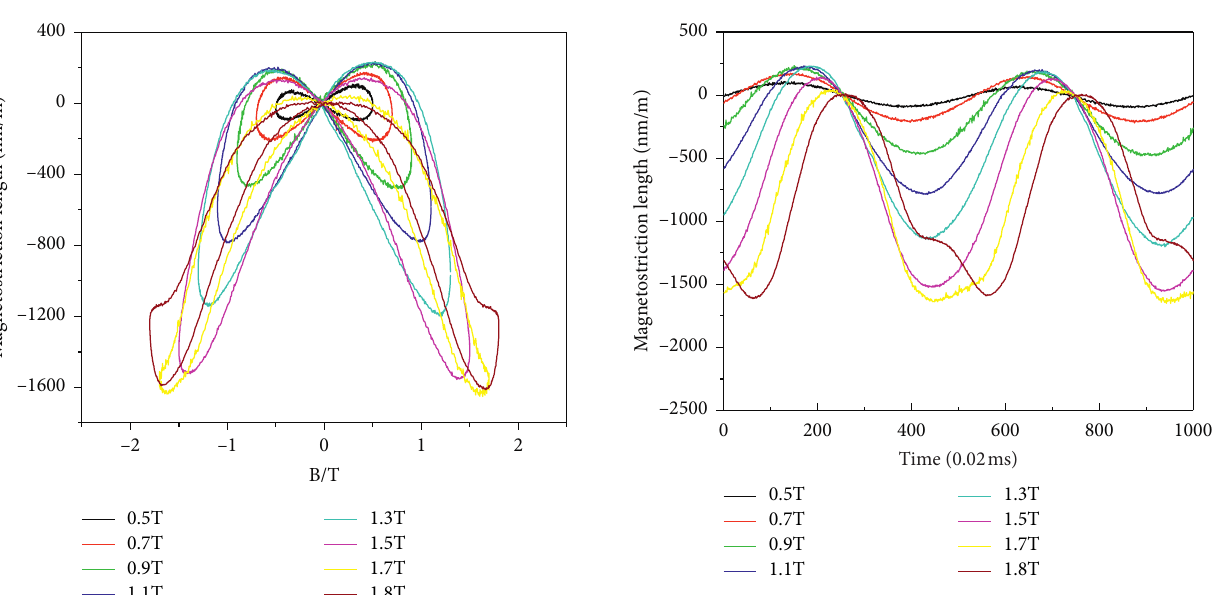
Figure 8: Time-domain waveforms of magnetostriction at different magnetic flux densities.